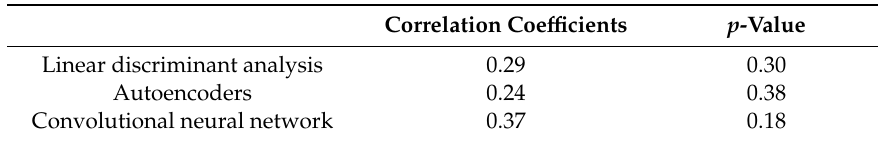
Table 9. Correlation analysis between the classification accuracies (mean across days) for the within-session calibration and the functional score (upper limb Fugl-Meyer